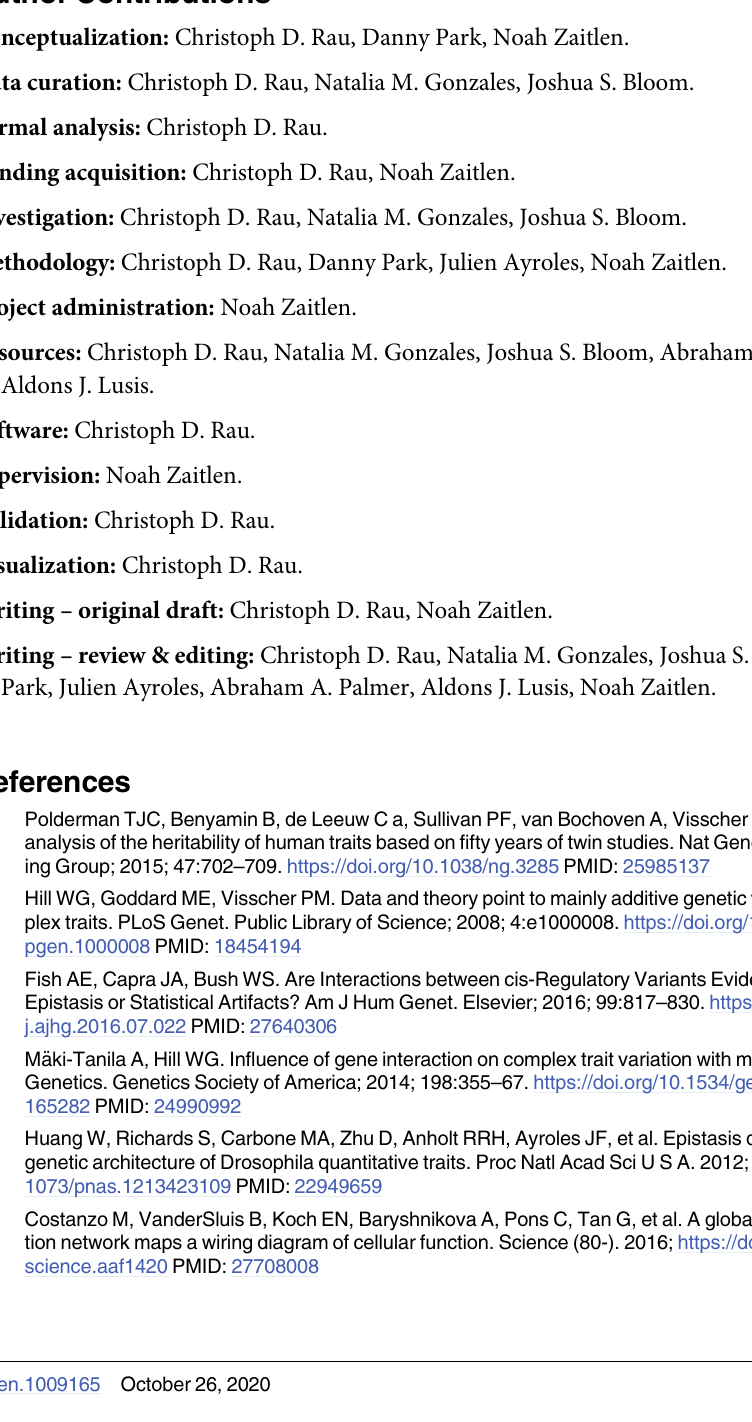
S10 Table. All significant Gx θ associations for HMDP transcriptome data.